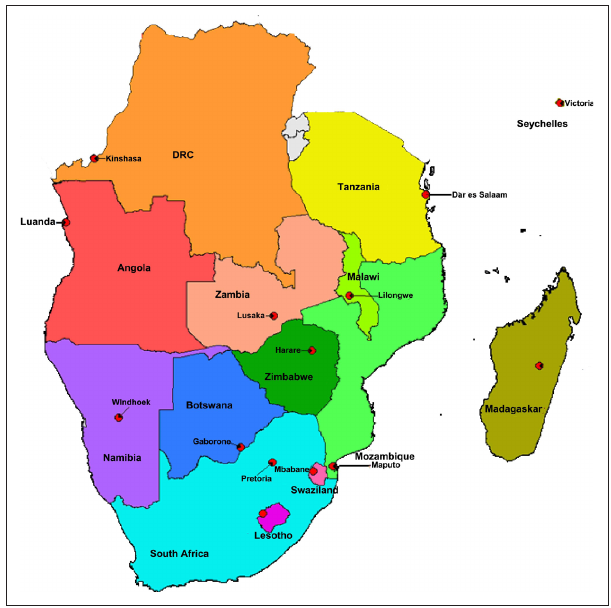
FIGURE 2: Map of Namibia with other SADC